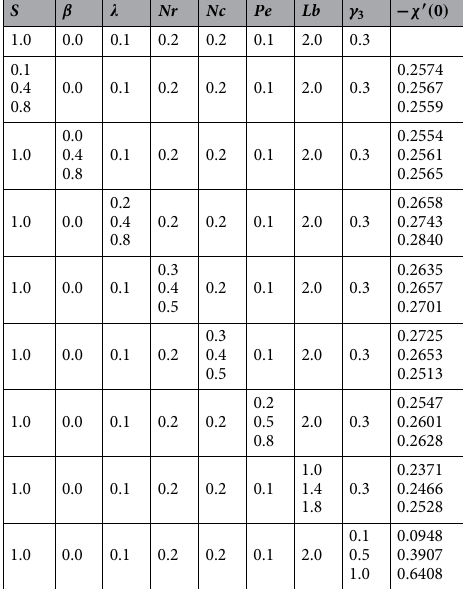
Table 2. Tabulations of − χ ′ ( 0 ) with variations of α , S , β , (cid:31) , Nr , Nc , Pe , Lb and γ 3